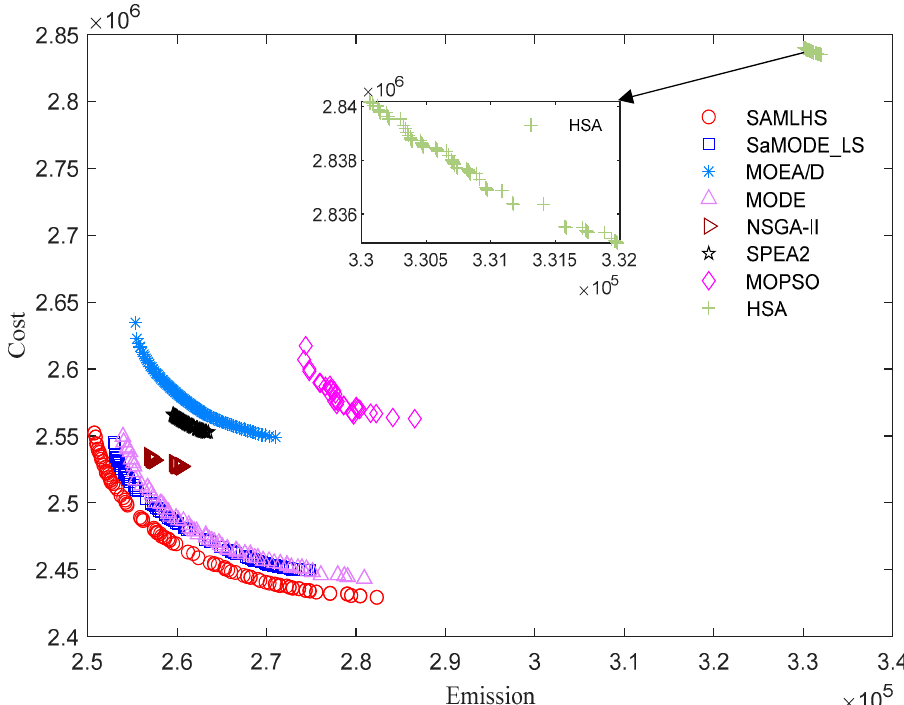
Figure 1. The PFs obtained by different algorithms. Table 6. The solutions for different algorithms ( F C